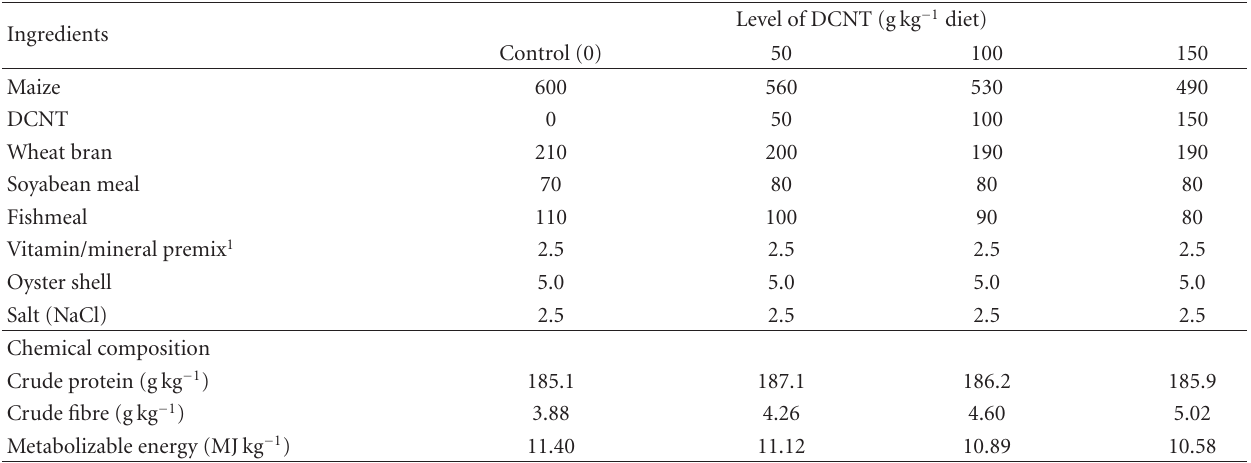
Table 1: Composition of experimental